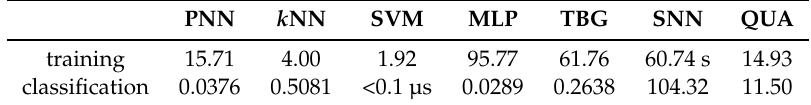
Table 5. Algorithm performance for gesture recognition, time in milliseconds. The training time was measured for classes size of 1. The classification time was measured for one